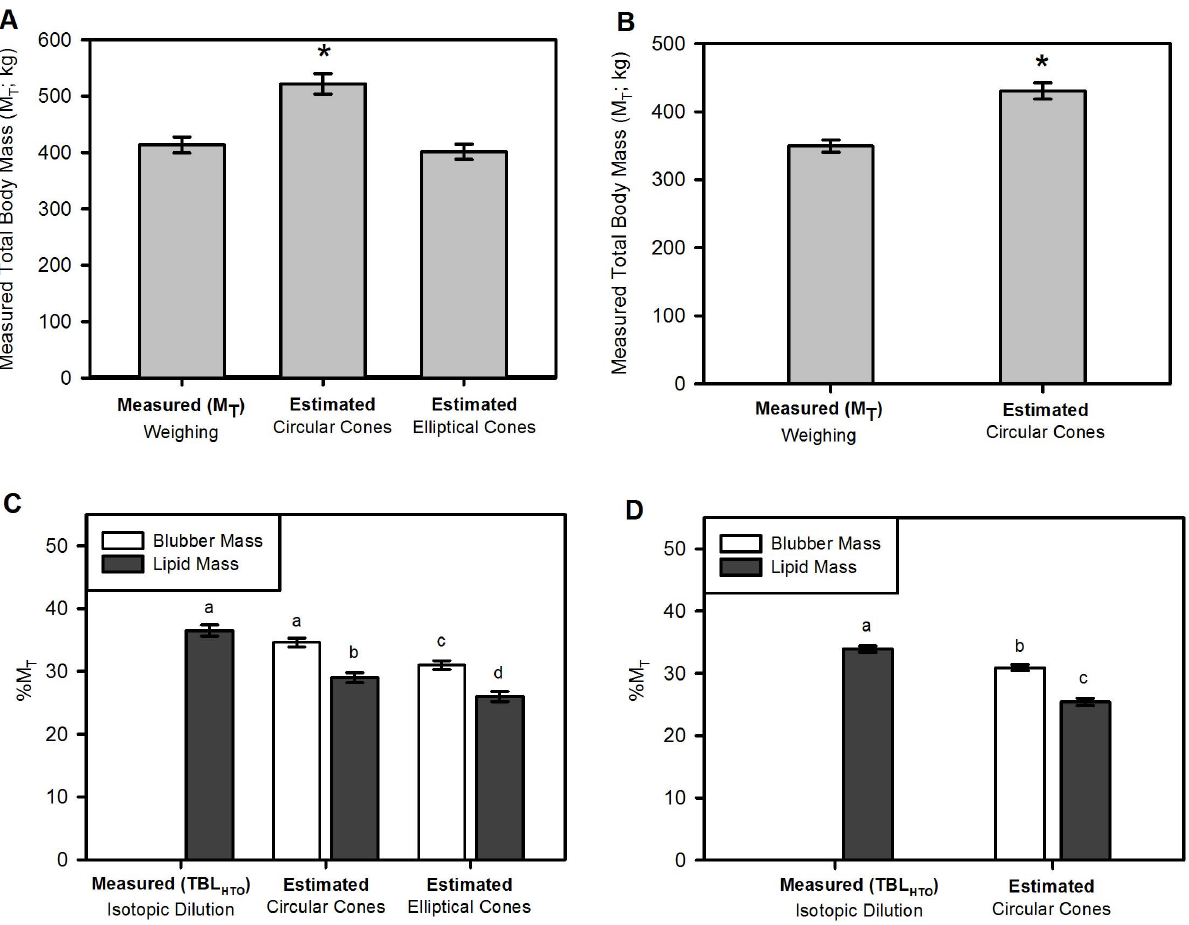
Figure 4. Estimated mass and body composition using truncated cones methods relative to measured values. Mean 6 SE estimated total body mass (M T ) from the ‘‘subset study’’ ( A ; N =10) using both circular and elliptical truncated cones, and ( B ) from the ‘‘full study’’ ( N =76) using circular truncated cones. Body composition estimated ( C ) from circular and elliptical cones in the subset study and ( D ) circular cones from the full study are also shown. Blubber with or without corrections for lipid content were compared to total body lipid determined via isotopic dilution (TBL HTO ). *= significant difference between estimated and measured M T . Different letters= significant difference between body composition estimates relative to measured lipid